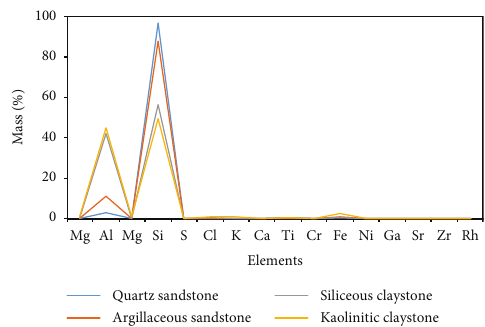
Figure 3: Elemental composition of the tested rock samples (perspective